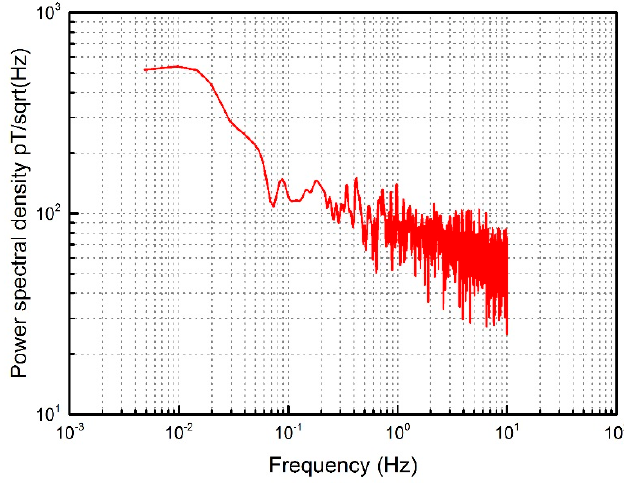
Figure 10. Power spectrum density of RTD with SFTD method.